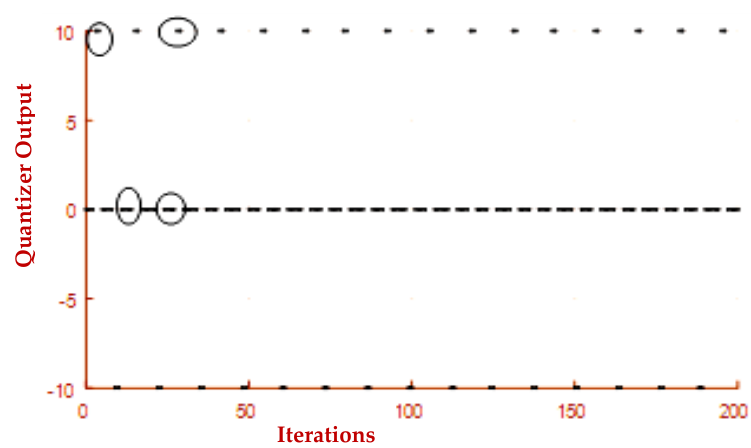
Figure 6. Plot of Quantizer Output as a function of iterations.